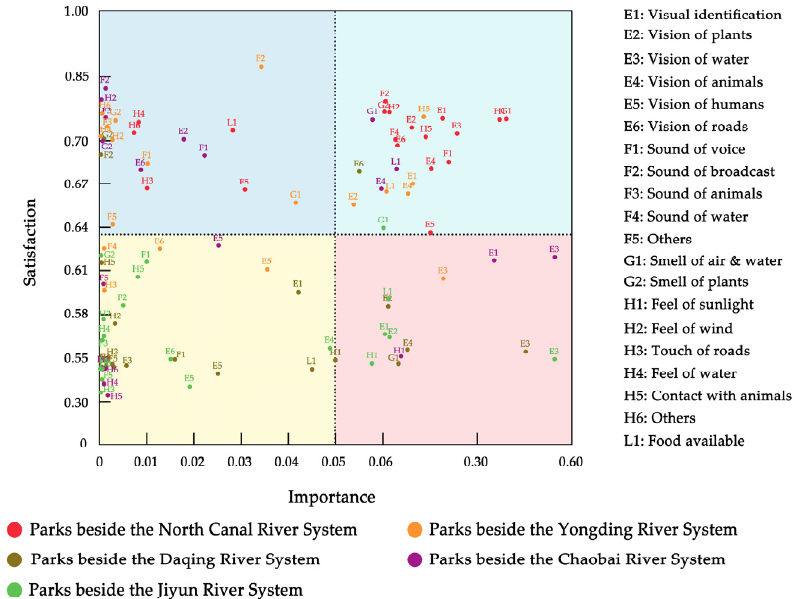
Figure 6. IPA model of riverside parks beside different river systems based on spatial landscape design.